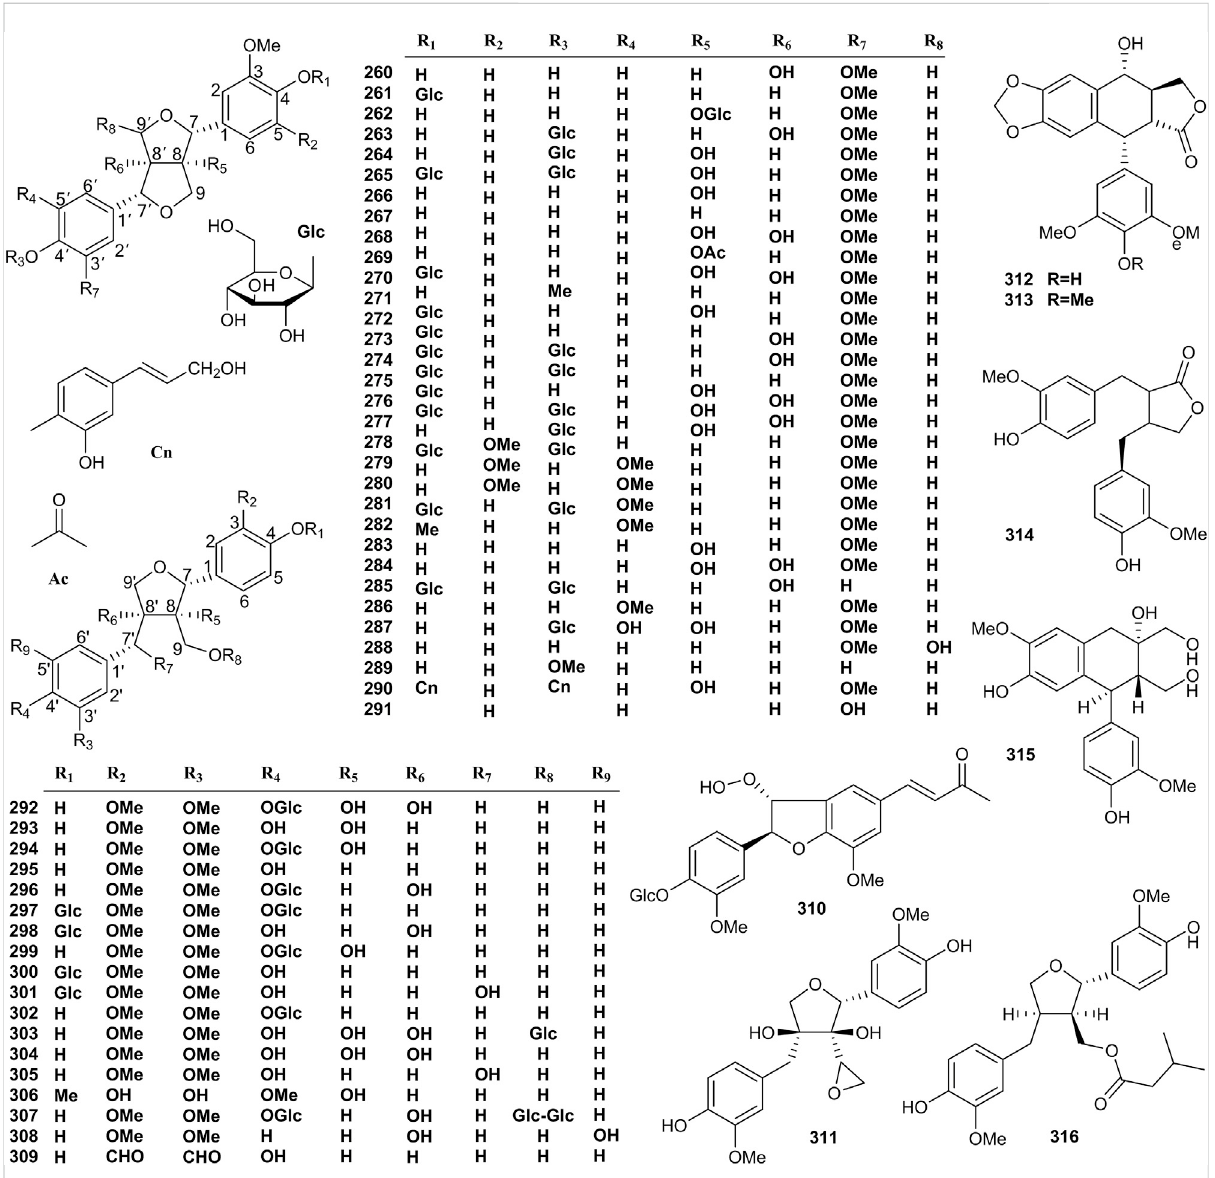
FIGURE 6 Structures of lignans from the genus Valeriana